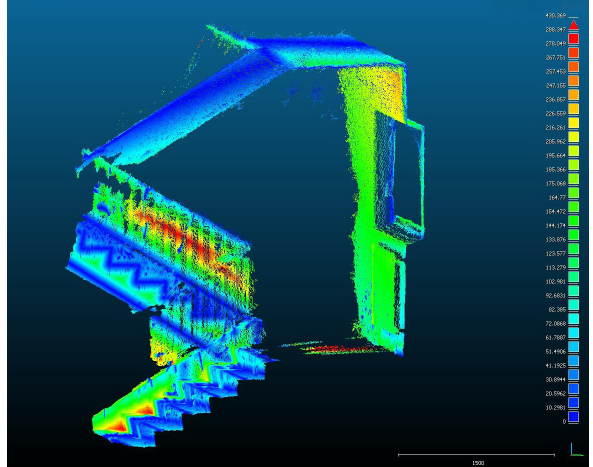
Figure 7: Vertical section of IBM generated point cloud and TLS point